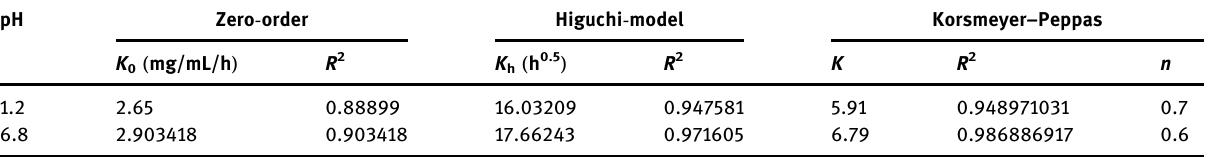
Table 3: Modelling of glutathione release kinetics from the selected formulation GTN8 in the stomach ( pH 1.2 ) and intestine ( pH 6.8 ) pH Zero - order Higuchi - model Korsmeyer –